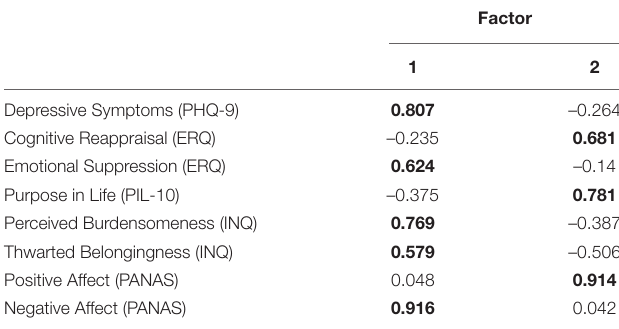
TABLE 4 | Factor loadings of participants’ health and psychological strategies.